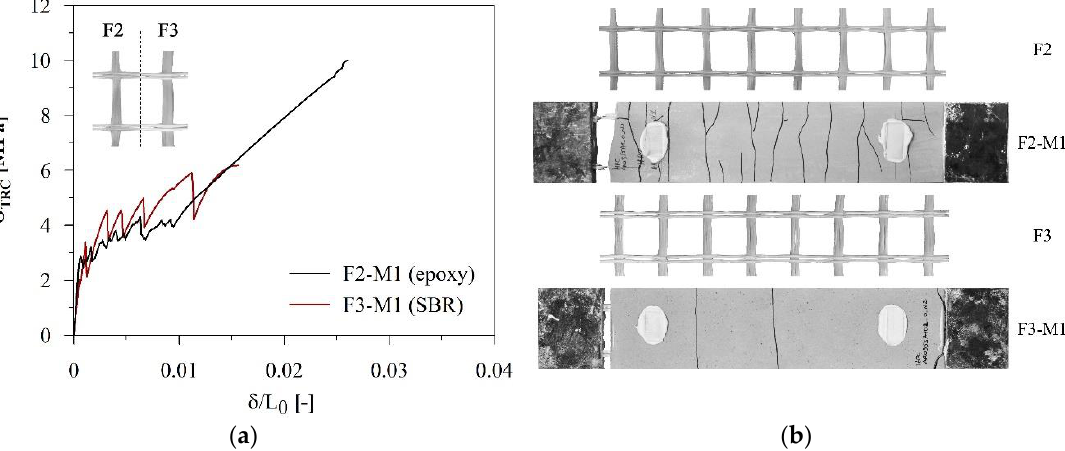
Figure 7. Effect of different coatings on the uniaxial tensile response ( a ); and on the cracking pattern ( b ) of M1-based composites reinforced with geometrically identical F2 and F3 fabrics.